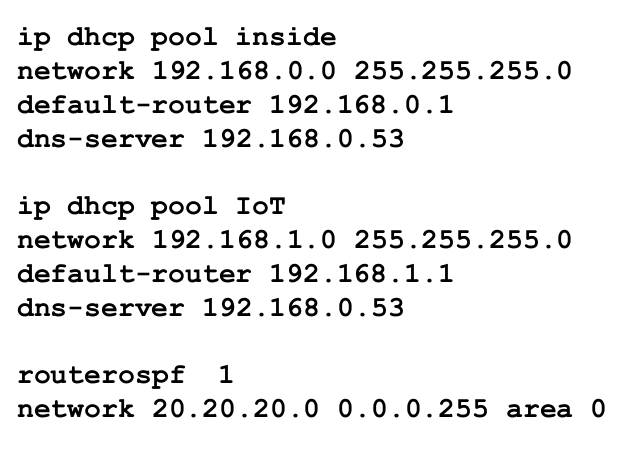
Figure 3. DHCP setup on the home